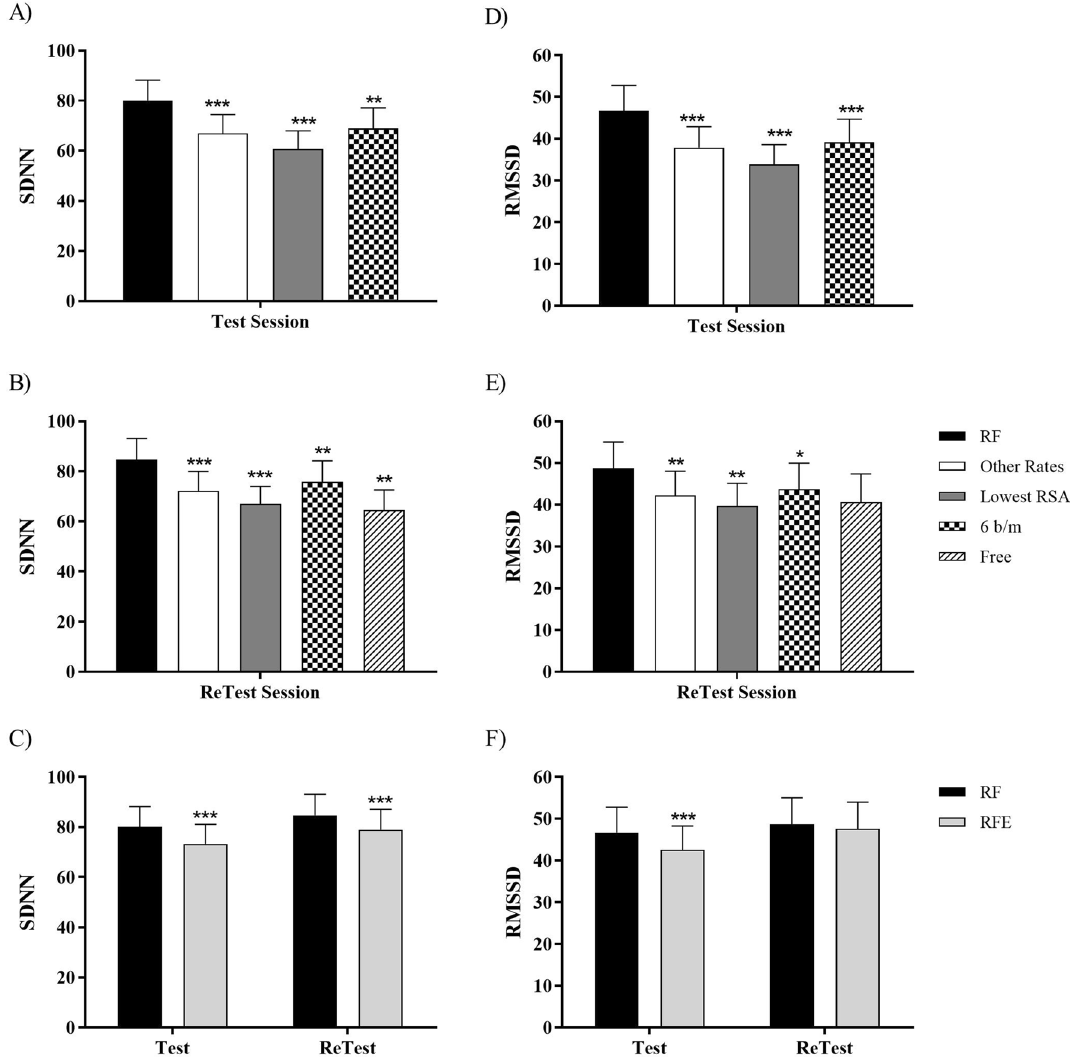
Figure 5. HRV time domain parameters: SDNN ( A – C ) and RMSDD ( D – F ) for Test ( A , D ), ReTest ( B , E ) and RF-RFE comparison ( C , F ). “RF” represents the optimal resonance frequency, “Other Rates” represents the mean of the other breathing rates, “Lowest RSA” represents the lowest RSA amplitude, “6 b/m” represents the rate of 6 breathes per minute, “Free” represents the free slow breathing session only in retest, and “RFE” represents the expanded RF that consists on taking the SDNN/RMSSD of the nearest below and above rates from the RF. Non- parametric Wilcoxon test has been performed. * (p < 0.05), ** (p < 0.01) and *** (p < 0.001) mean differences with respect to RF in the same